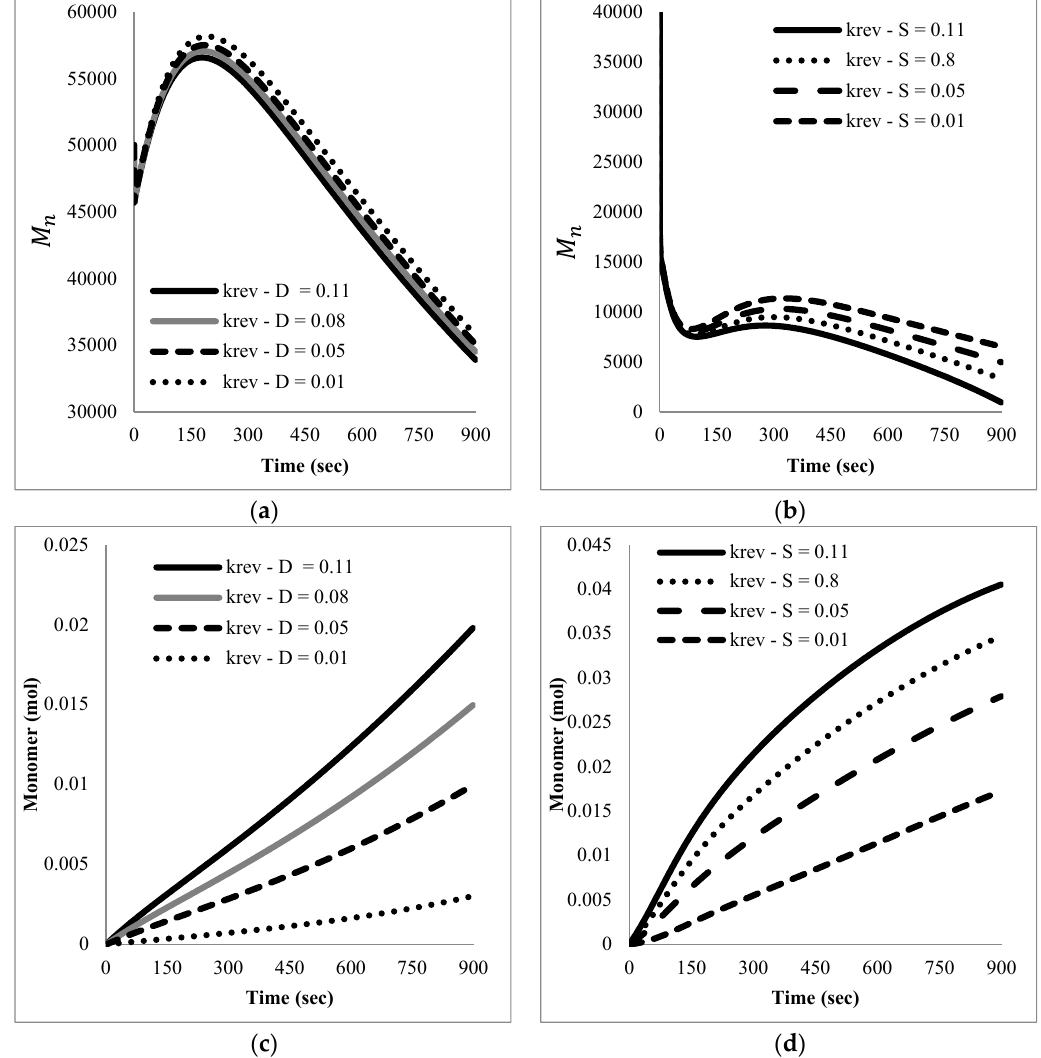
Figure 10. Effect of the variation of the reverse propagation coefficient value, k rev , on the pyrolysis M n evolution of ( a ) dead polymer and ( b ) dormant polymer, and on the monomer generation of ( c ) dead polymer and ( d ) dormant polymer.